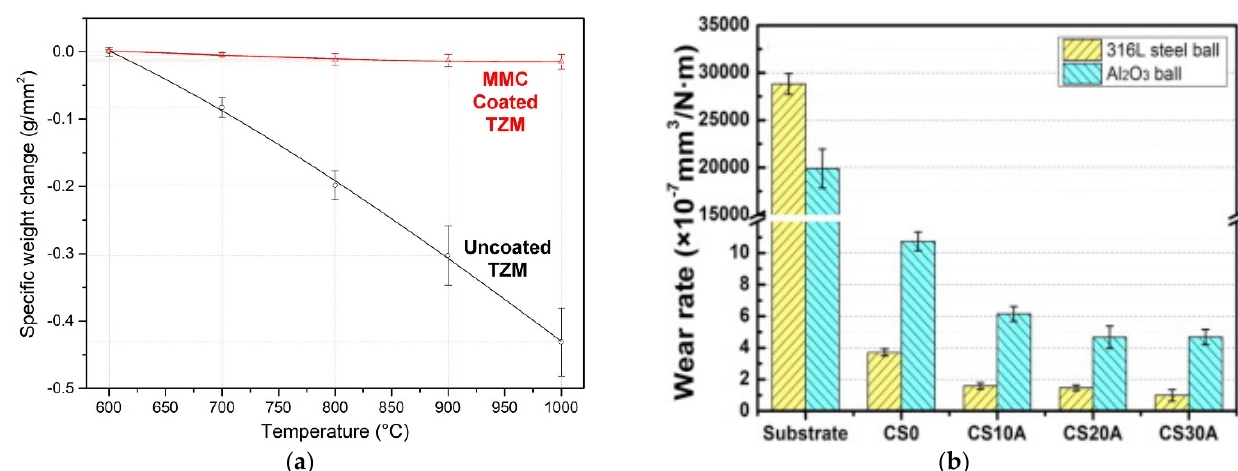
Figure 14. The specific mass changes of the TZM substrate and Ni-Zn-Al 2 O 3 coating after high-temperature oxidation tests ( a ) (Reprinted with permission from [156]. Copyright 2020 Elsevier.) and wear rate in artificial seawater of CuSn5 + Al 2 O 3 (0, 10, 20, 30 wt%) coatings and aluminium alloy 7075-T651 substrate ( b ) (Reprinted with permission from [143]. Copyright 2012 Elsevier ).